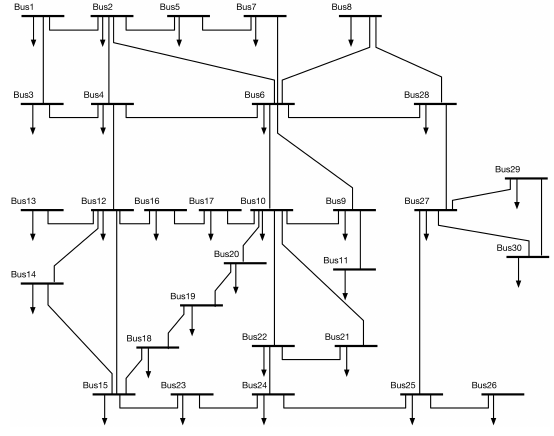
Figure 15. IEEE 30 bus